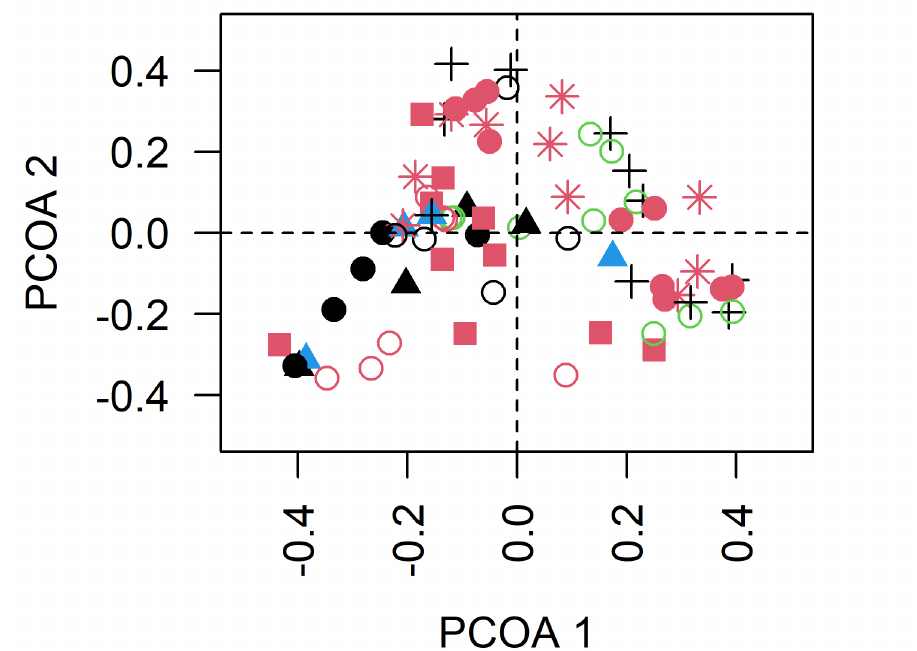
FIGURE 2 | Results of the Principal Coordinates Analysis (PCoA) based on the Bray-Curtis dissimilarity matrix of the taxonomic composition of the fish larvae in relation to the sites sampled in the upper Paraguay River basin in Mato Grosso State, western Brazil. CAB1 = Cabaçal River site 1 (closed black circle); CAB2 = Cabaçal River site 2 (closed red circle); FOR = Formoso River (black triangle); JAU = Jauru River (red asterisk); JUB = Juba River (blue triangle); PAR = Paraguay River (black cross); SEP1 = Sepotuba River site 1 (open black circle); SEP2 = Sepotuba River site 2 (open red circle); SEP3 = Sepotuba River site 3 (open green circle); VERN = Vermelho River (red